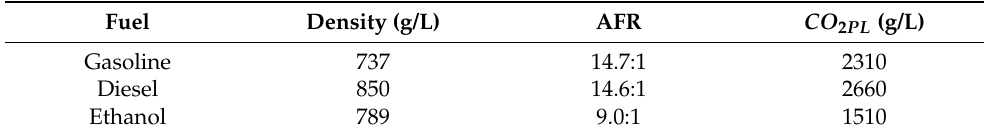
Table 3. Fuel conversion